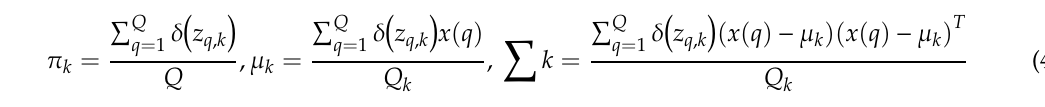
Figure 5. The scheme of target detection and tracking.